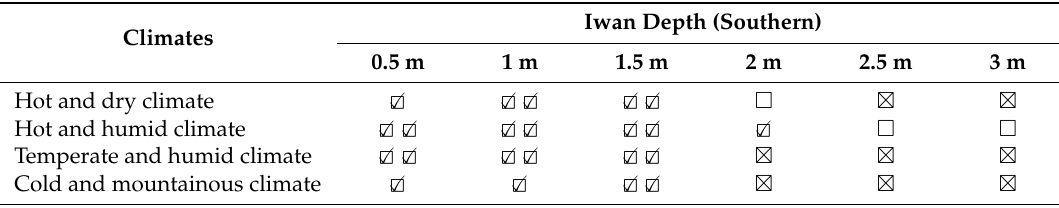
Figure 8. Thermal loads of southern zone based on the Iwan depth [KW/Yearly]. Table 9. General analysis of thermal performance in different depth of Iwan in buildings.